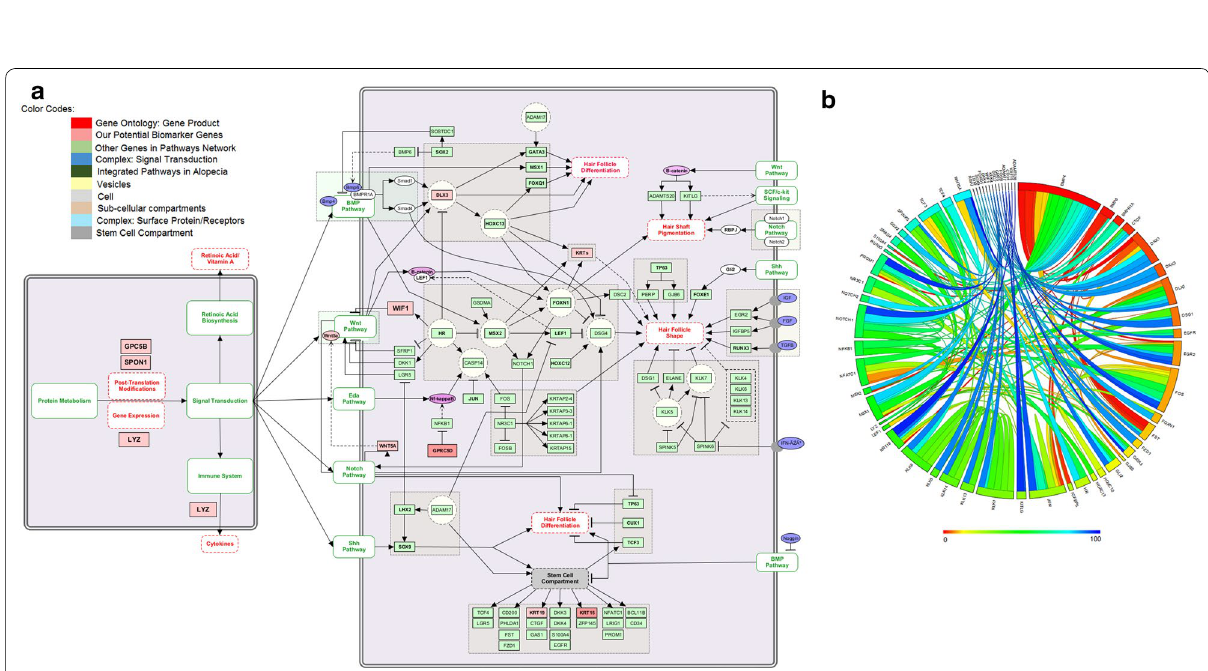
Fig. 7 Reactomic analysis and molecular mechanisms in alopecia. a The role of integrated pathways in hair follicle differentiation, hair follicle shape, hair shaft pigmentation, and hair development. The pathways have been mapped using KEGG, Reactome and Wiki Pathways. Color codes are used to describe reaction steps of pathway model. b Circos Graph generated by Gene Terrain indicates the expression levels and the relationship of differentially expressed genes of each